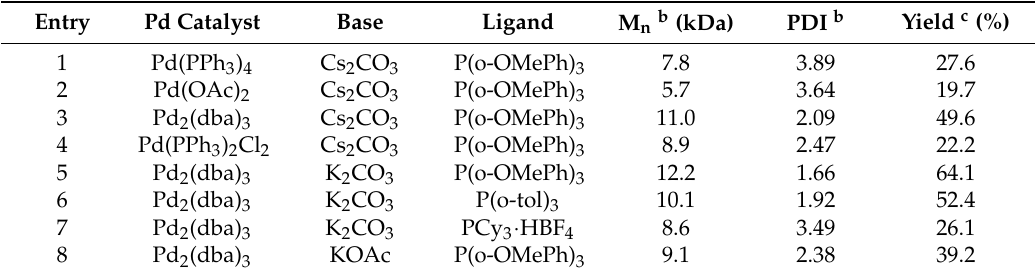
Table 2. Optimization of reaction conditions of PhI and dibromothiophene by DHAP a